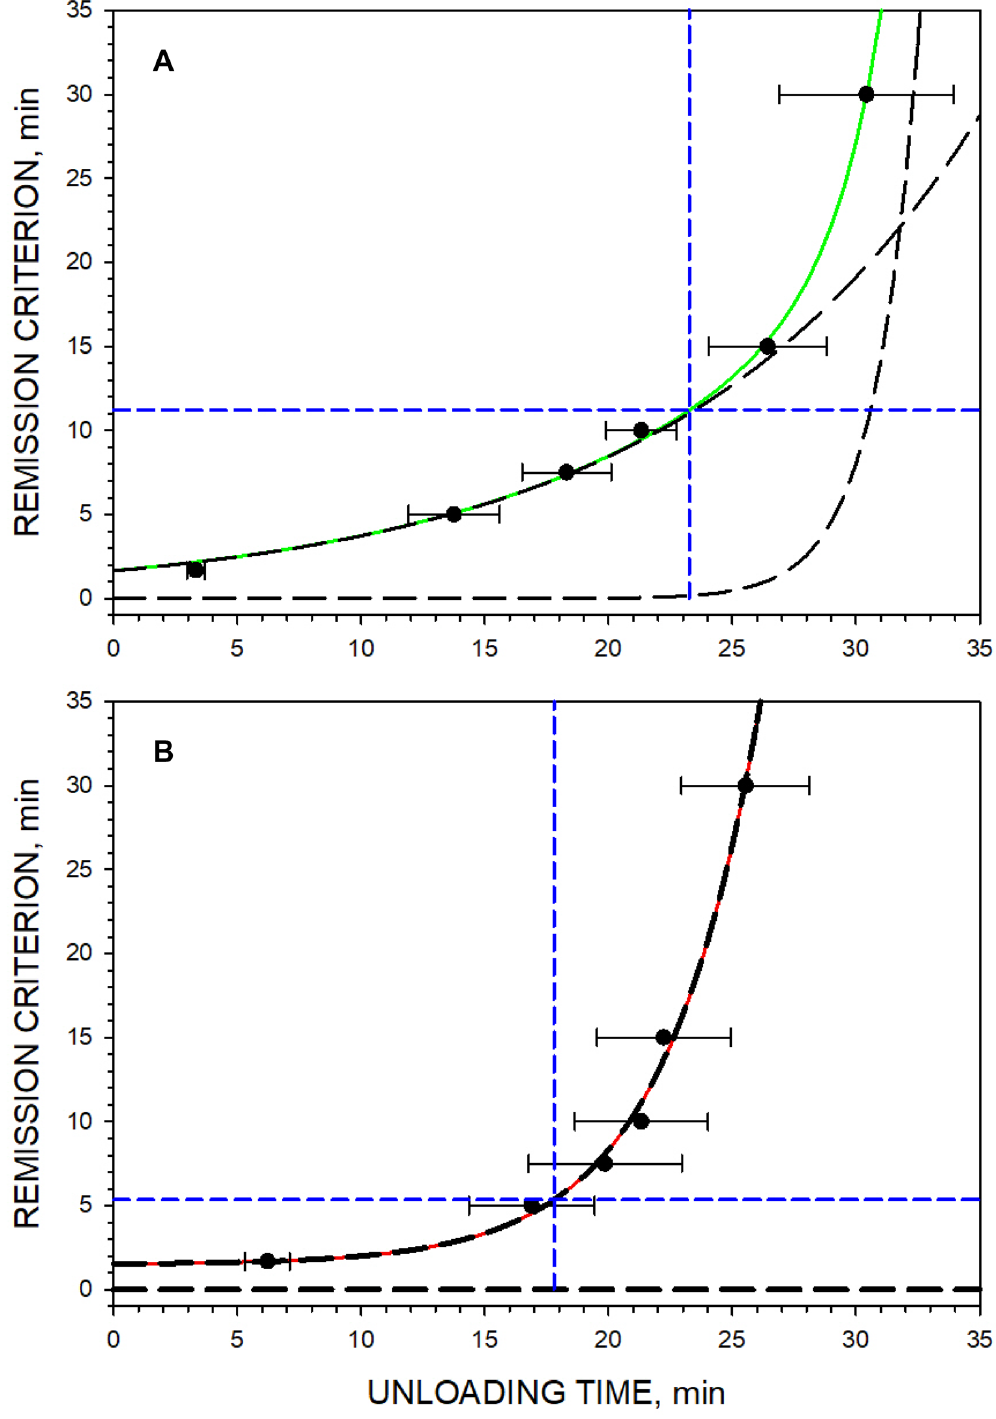
Figure 2. Survival analyses of long IPIs as a function of elapsed unloading time during Baseline FR1 sessions (Panel A ) and during Post-PR FR1 sessions (Panel B ). Symbols represent the mean ± SEM unloading duration (ED 50 ) in 6 rats at which the first preset long interval occurs (see y -axis). The solid lines represent the best fit of the nonlinear regression analysis according to y = y 0 + a ·exp( b·x ) + c ·exp( d·x ). In panel ( A ), solid green line: y 0 = 5.14∙e –9 , a = 1.65, b = 0.08, c = 3.43∙e –7 and d = 0.57. In panel ( B ), solid red line: y 0 = 1.49, a = 1.65, b = 0.26, c = 0.00 and d = 0.00. Long dash lines (bold) represent the two exponential components separately. The horizontal short dash lines represent the best remission criteria estimates of 11.22 min (673 s; panel A ) and 5.35 min (322 s; panel B ) when the slope of solid lines, the first derivative, was unity: y ´ = a·b· exp( b·x ) + c·d· exp( d·x ) = 1. The vertical short dash lines represent the border between slow and fast raising parts of the function at the elapsed unloading time (Panel A : 23.26 ± 2.69 min; Panel B : 17.80 ± 2.72 min) dividing unloading and remission phases. SigmaPlot v. 14.0 (https:// systa tsoft ware.